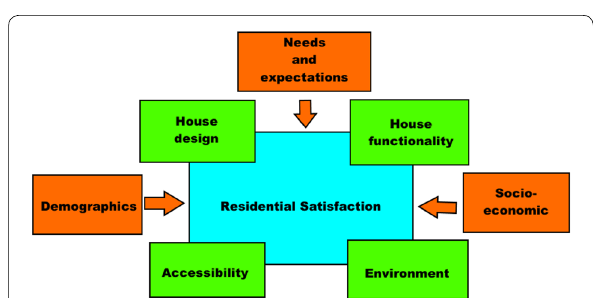
Fig. 5 Schematic representation of the residency satisfaction measurement